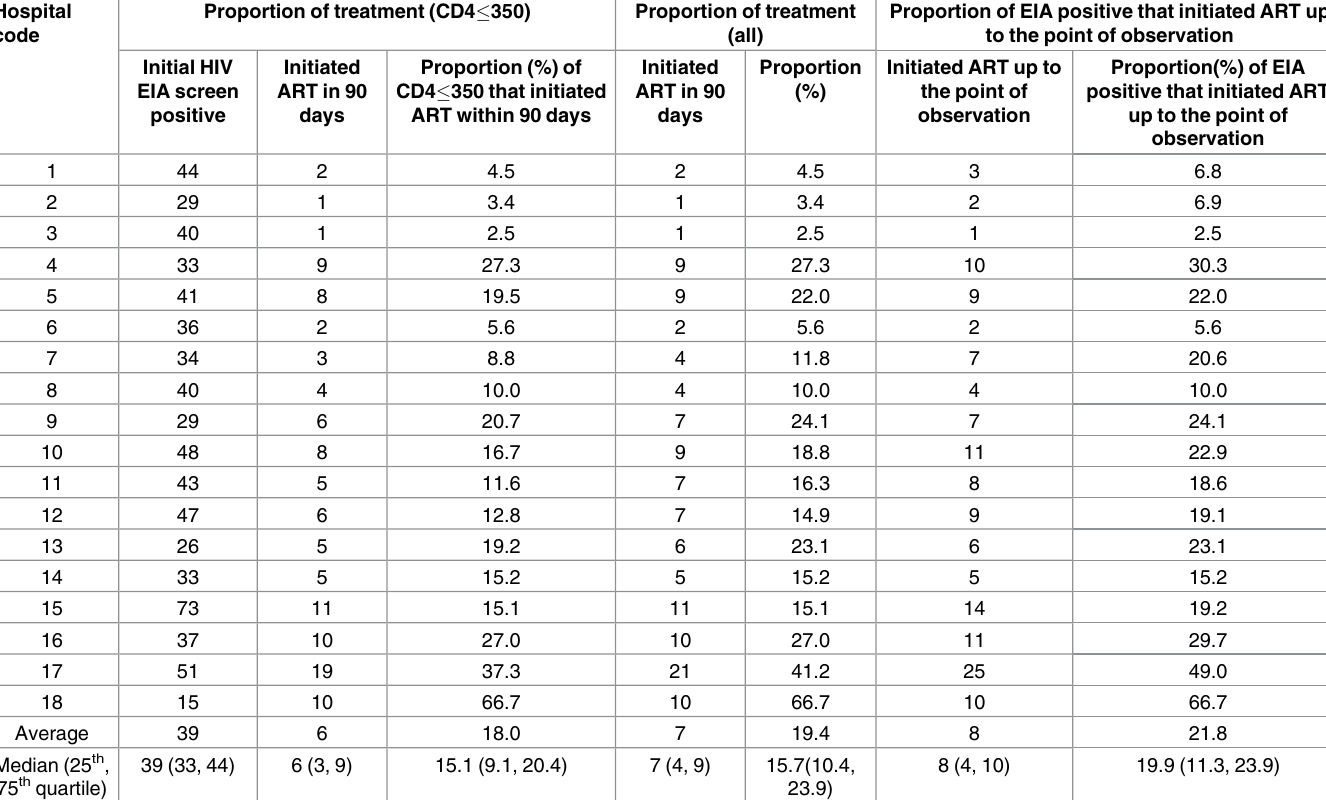
Table 3. The proportions initiating treatment in 18 county hospitals in Guangxi between January 1 and June 30, 2013. Hospital Proportion of treatment (CD4 (cid:20) code